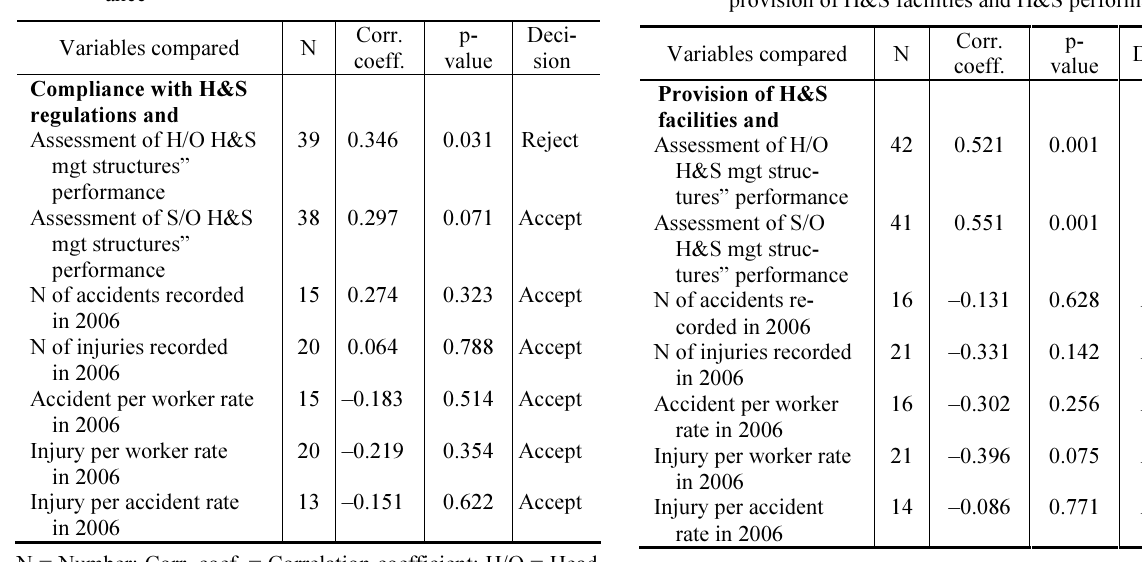
Table 2. Results of Spearman correlation between contractors’